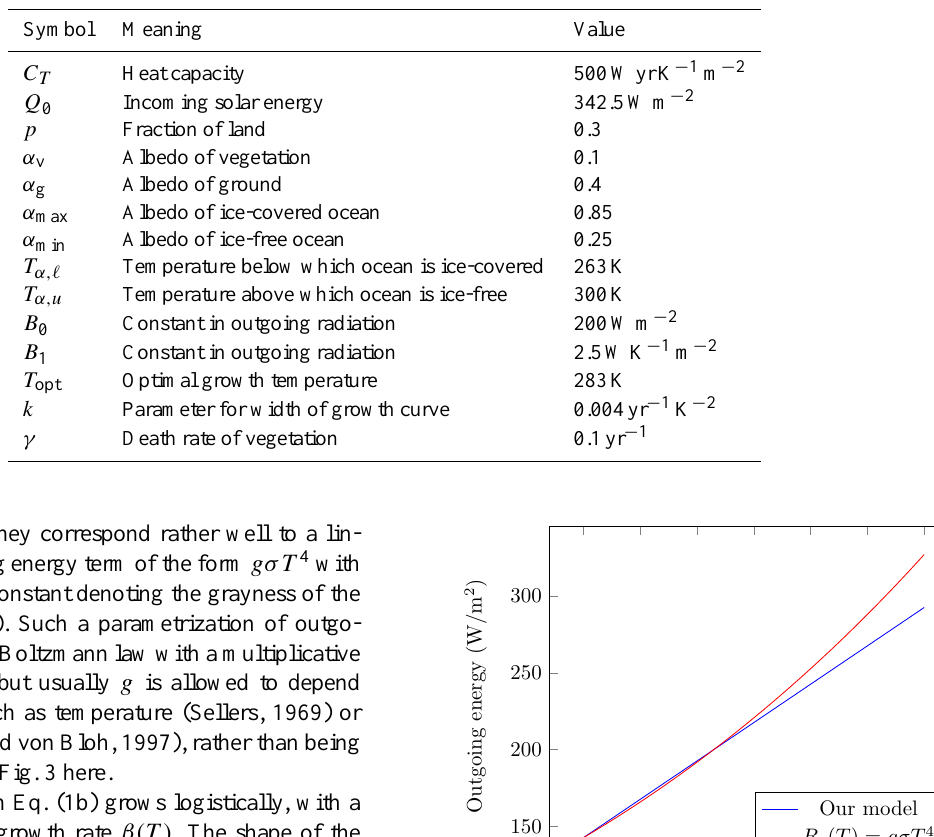
Table 1. Definition and values of the model parameters.